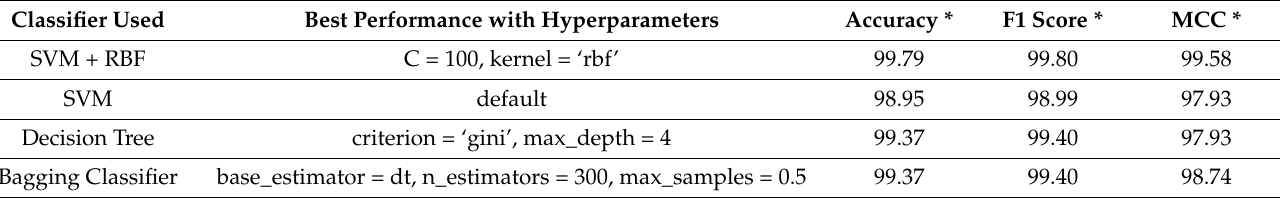
Table 3. Estimated performance over Dataset-2 under case-1.